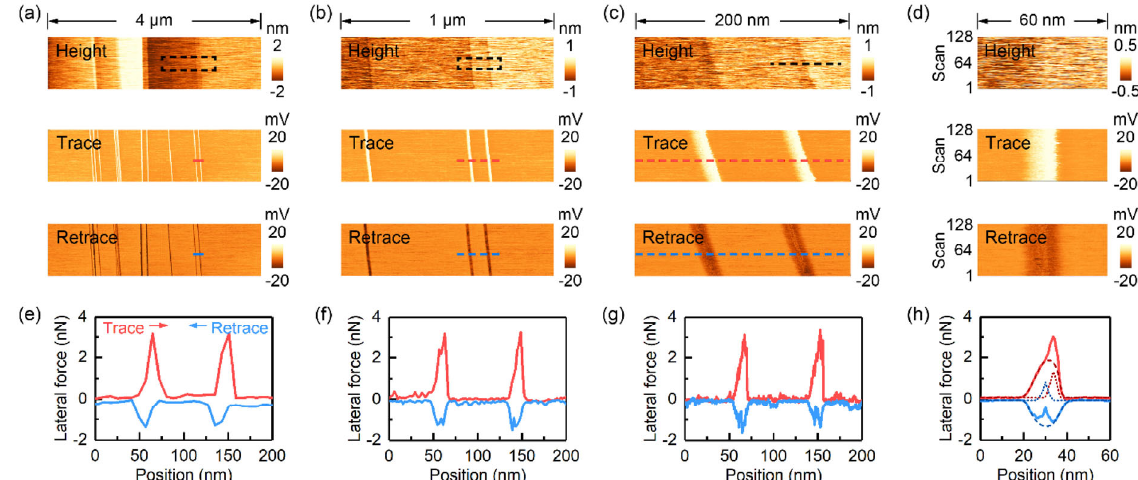
Fig. 2 Revealing fine features in the friction response of 0.3 nm thick single-layer graphene step edges exposed to air. (a) shows the topography, and trace and retrace lateral signal images of a 4  m  1  m area. (b) shows the data collected in the dash-box in (a), and (c) shows the data collected in the dash-box in (b). (d) shows the data of 128 scans along the black dash-line in (c). The scan rate was kept constant at 2 Hz and each scan line consists of 512 pixels. The trace and retrace lateral signals shown in (e–g) are from the single line profile marked in (a–c), respectively. (h) shows the lateral signal line profile averaged from the 128-scan data in (d). The lateral signal in (h) is deconvoluted into two components. The applied normal load between the tip and the graphite surface was 5